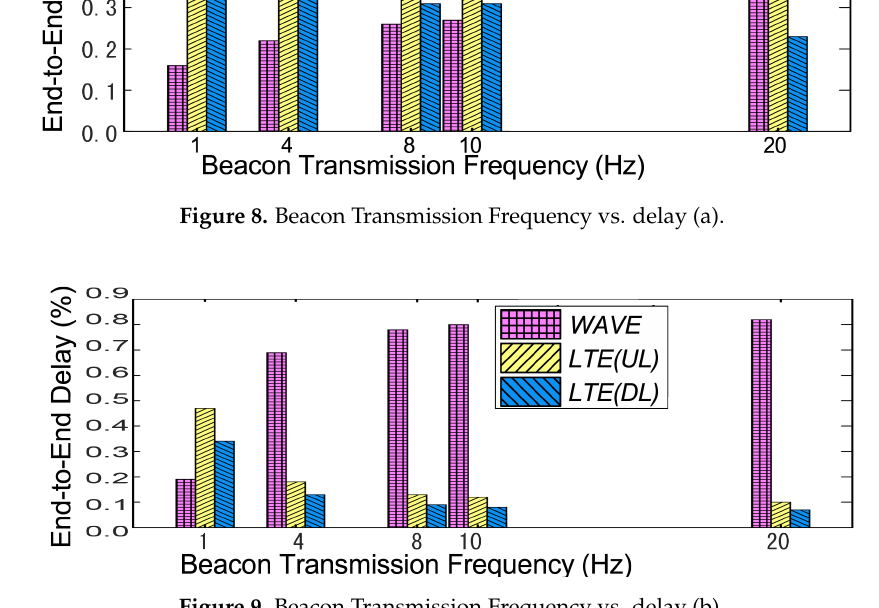
Figure 9. Beacon Transmission Frequency vs. delay